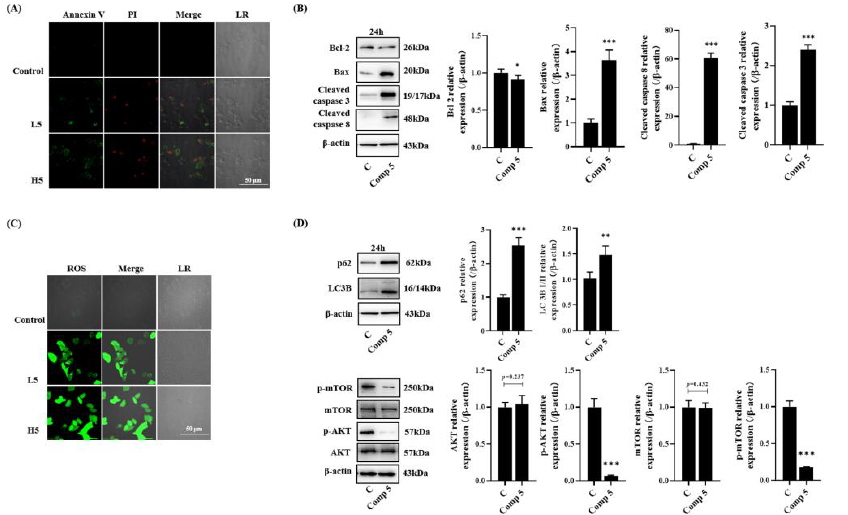
Figure 2. Compound 5 promoted the apoptosis of HepG2 cells. ( A ) Fluorescence image of cell apoptosis in HepG2 cells. The cells were double stained with Annexin V and PI. Early apoptotic cells were stained with Annexin V, and late apoptotic cells were stained with PI. ( B ) HepG2 cells were treated with Compound 5 (25 μmol∙L −1 ) for 24 h, and the protein expression was detected by western blot. ( C ) Fluorescence image of ROS in HepG2 cells. ( D ) HepG2 cells were treated with Compound 5 (25 μmol∙L −1 ) for 24 h, and autophagy-related protein expression and AKT/mTOR were detected by western blotting. Data are expressed as the mean ± standard deviation. * p < 0.05, ** p < 0.01, *** p < 0.001 vs. the control group.